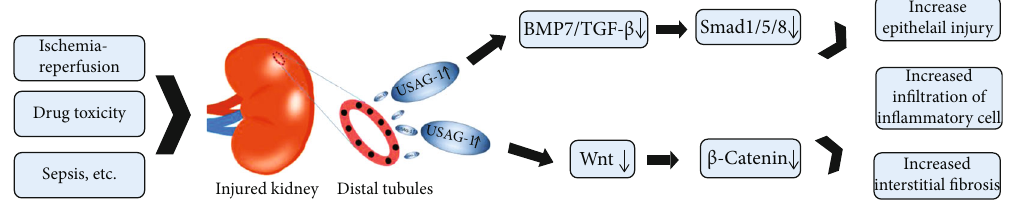
Figure 1: Theoretical e ff ects of USAG-1 in renal diseases. The secretion of USAG-1 in the distal tubule increases when the kidney is damaged by ischemia reperfusion, drug toxicity, sepsis, or other factors. It aggravates tubule damage, in fl ammatory cell in fi ltration, and interstitial fi brosis by a ff ecting the activity of the BMP7/TGF- β and Wnt/ β -catenin signaling